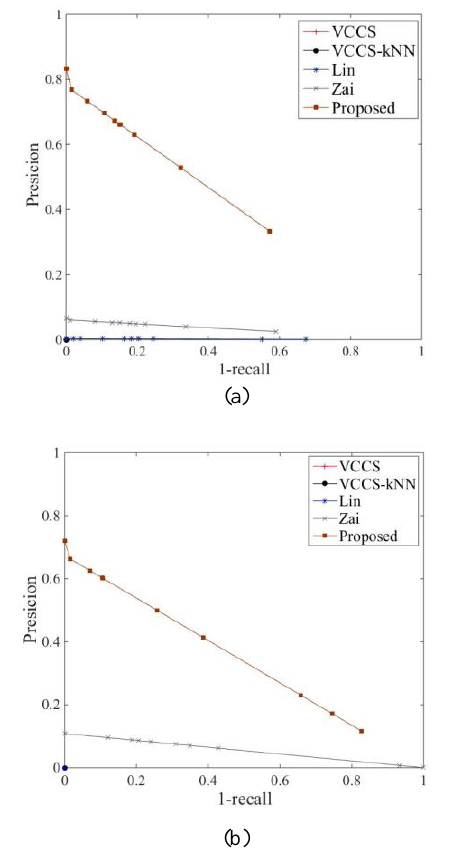
Figure 8. PR (precision-recall) curves of quantitative analysis in different supervoxel methods on two MLS road datasets. (a) Road1, (b) Road2.